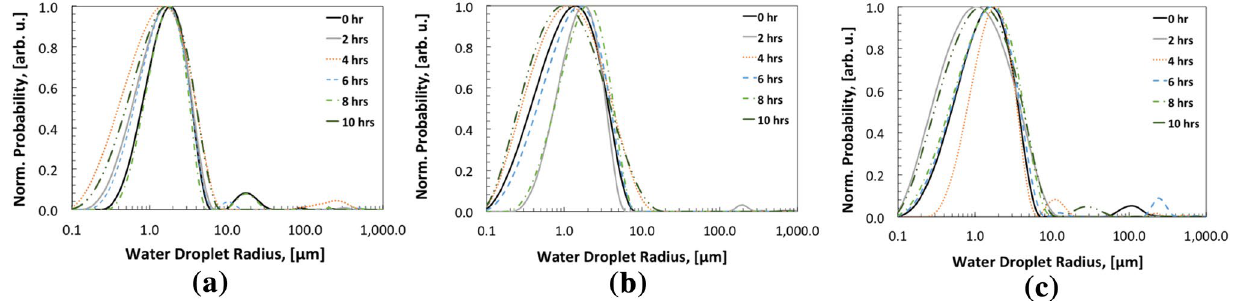
Fig. 9 Droplet size distributions for: a top, b middle and c bottom physical locations of water-in-oil emulsion formulated with AA-2 obtained from the PFG NMR diffusion experiments. This AA has resulted in much smaller droplets compared to the blank